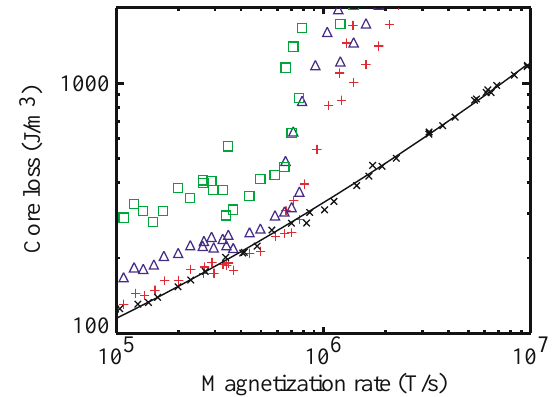
FIG. 16. (Color) Core loss versus magnetization rate for two METGLAS thin-SA1 cores, manufactured by NAM and MRTI. The data are for the listed flux swings: ( (cid:1) , green) NAM Thin- SA1-2 at 2.65 T; ( (cid:3) , blue) NAM Thin-SA1-2 at 2.40 T; ( 1 , red) NAM Thin-SA1-2 at 2.10 T; and ( 3 , black, solid line) MRTI Thin SA1-2 at 2.10 T.